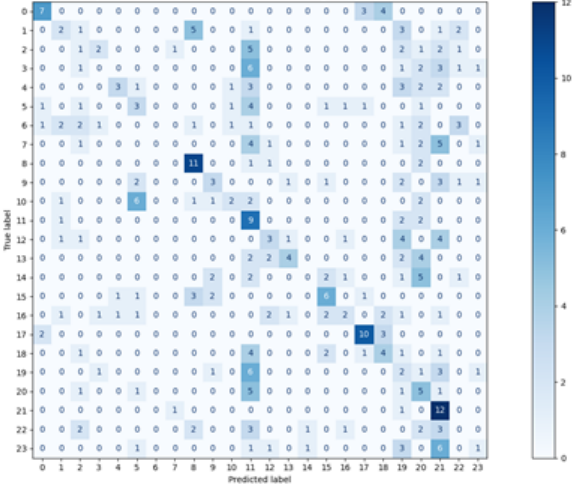
Figure 6. Confusion Matrix—Naive Bayes.